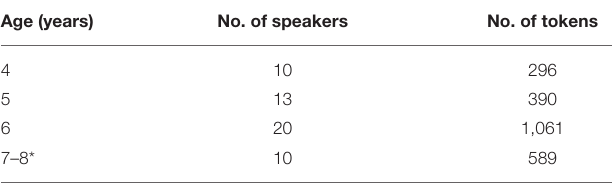
TABLE 1 | The number of speakers and tokens in each age